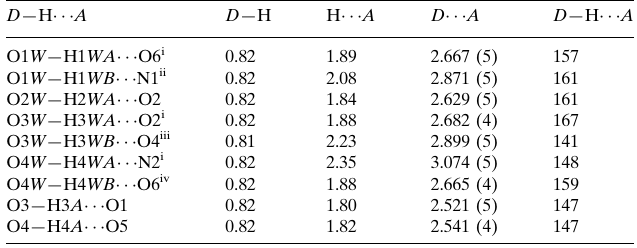
ligand acts as a